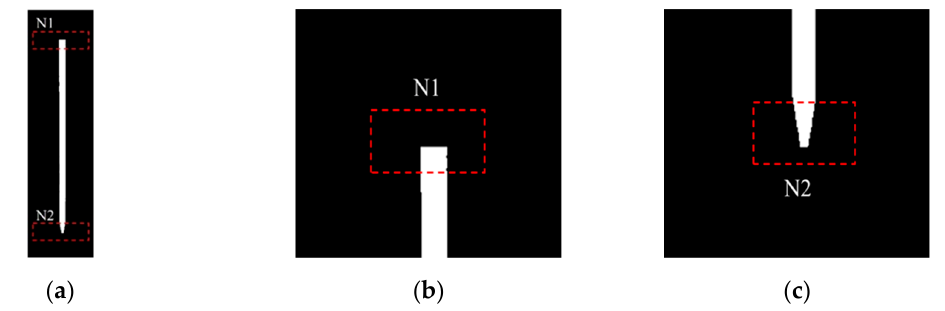
Figure 8. ( a ) Fine noise removed image of the cutting blade; ( b ) enlarged view of the mounted portion; ( c ) enlarged view of the tip showing a loss of data.